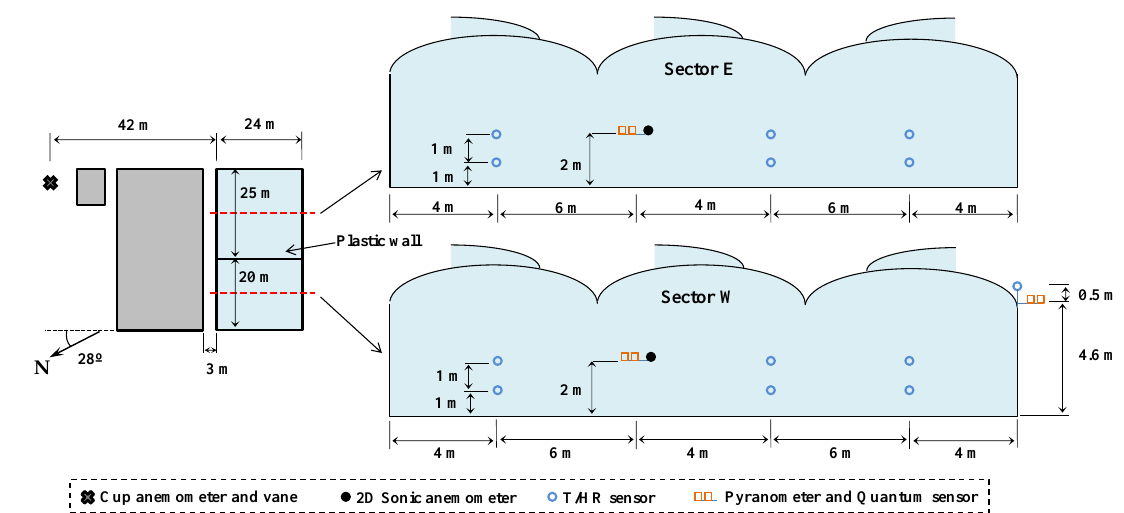
Figure 2. Location of the greenhouse sectors and layout of the climate sensors in the greenhouse.